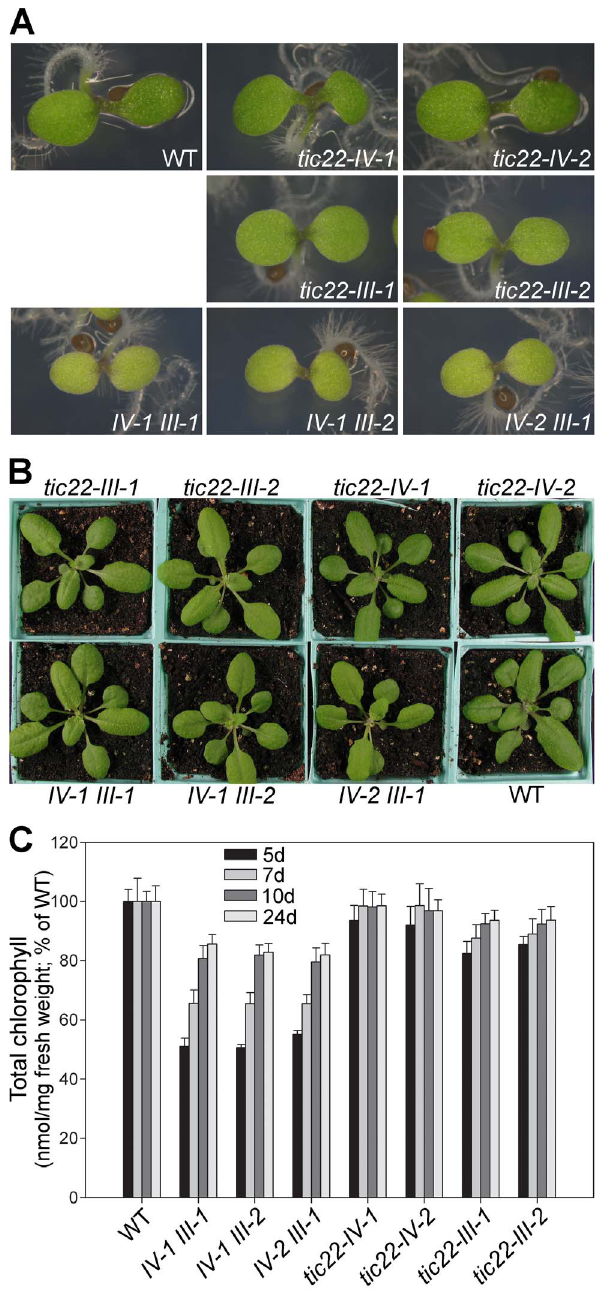
Figure 4. Phenotypic analysis of various tic22 single- and double-mutant plants. A, B. Homozygous plants of the indicated genotypes were grown side-by-side, in vitro , for five days (A), or for 14 days prior to transferral to soil and growth for an additional 10 days (B). Representative plants are shown. C. Chlorophyll concentrations in 5, 7, 10 and 24-day-old plants of the indicated genotypes are shown. The plants were grown in vitro or on soil as described in A, under identical conditions. Values shown are means ( 6 SE) derived from measurements of 12–24 different samples in each case. Units are nmol chlorophyll a + b per mg fresh weight, but the data have been normalized to the wild- type value at each developmental time-point.